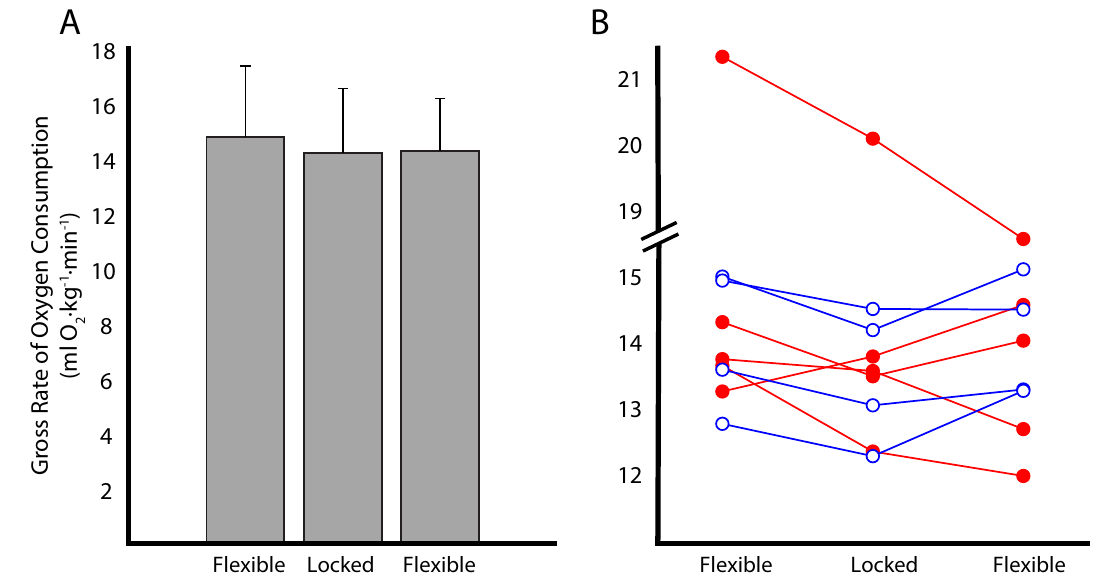
Figure 4. Effect of toe joint on gross rate of oxygen consumption. Results shown are from the A-B-A (Flexible- Locked-Flexible) study design. ( A ) Group means ( N = 9) with error bars representing standard deviations. ( B ) Individual participant data points are indicated by variations in marker shape and color. Filled markers (red) indicate the user preferred the Flexible toe joint configuration and empty markers (blue) indicate the user preferred the Locked toe joint configuration.